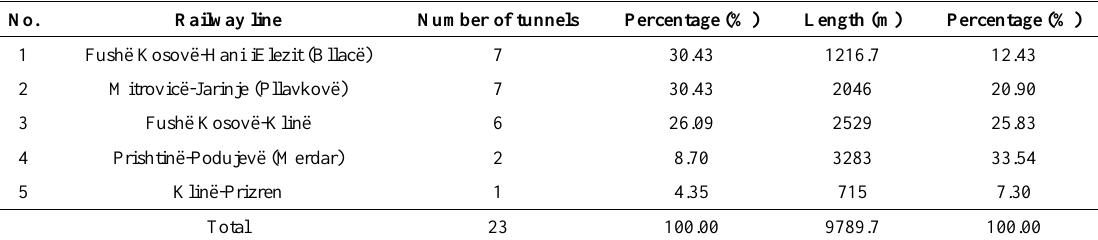
Table 5. Number of tunnels in the Kosovo railway network